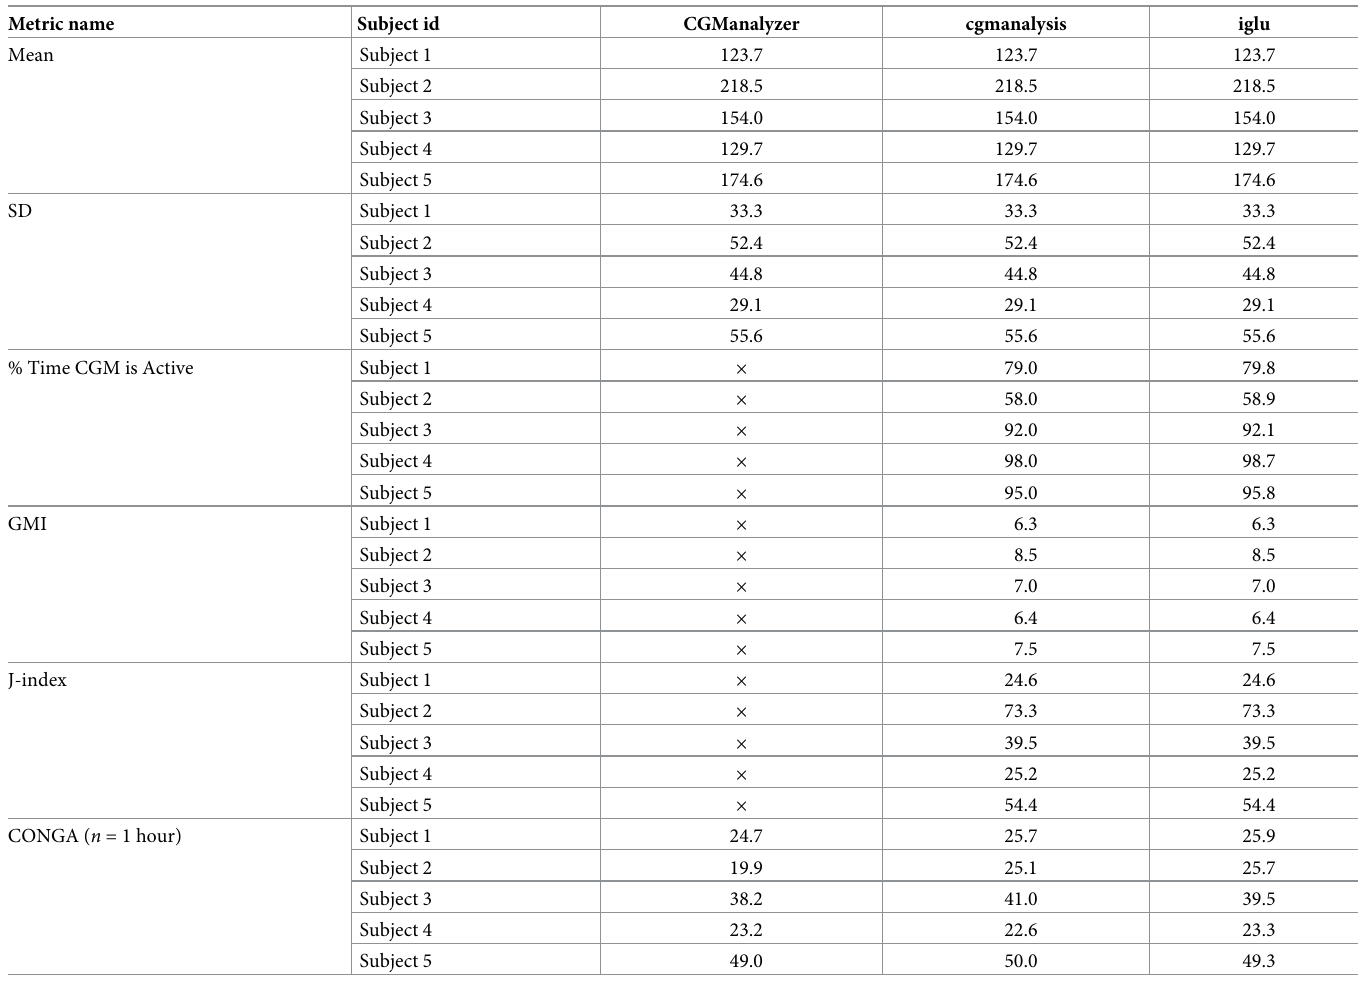
Table 3. Comparison of selected metrics across R packages using example dataset.